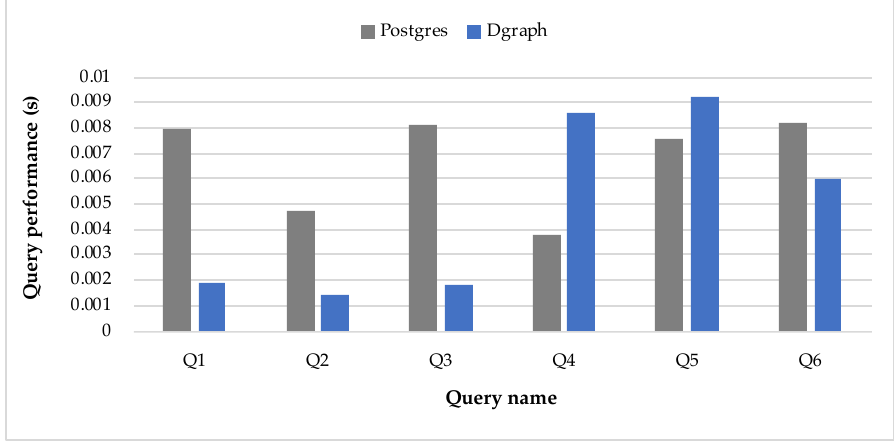
Figure 6. Query performance comparison between Postgres and Dgraph databases.